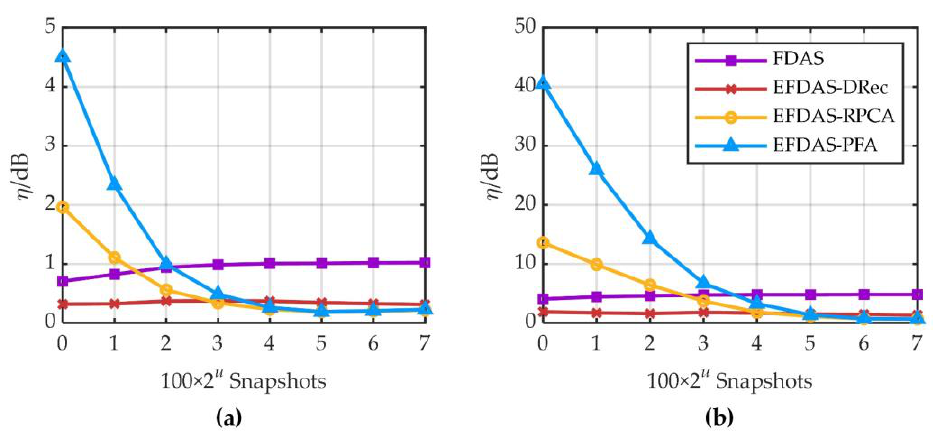
Figure 8. Average quantification error η under different numbers of snapshots: ( a ) Relatively strong sound sources (< − 10 dB); ( b ) Weak source ( − 15 dB).